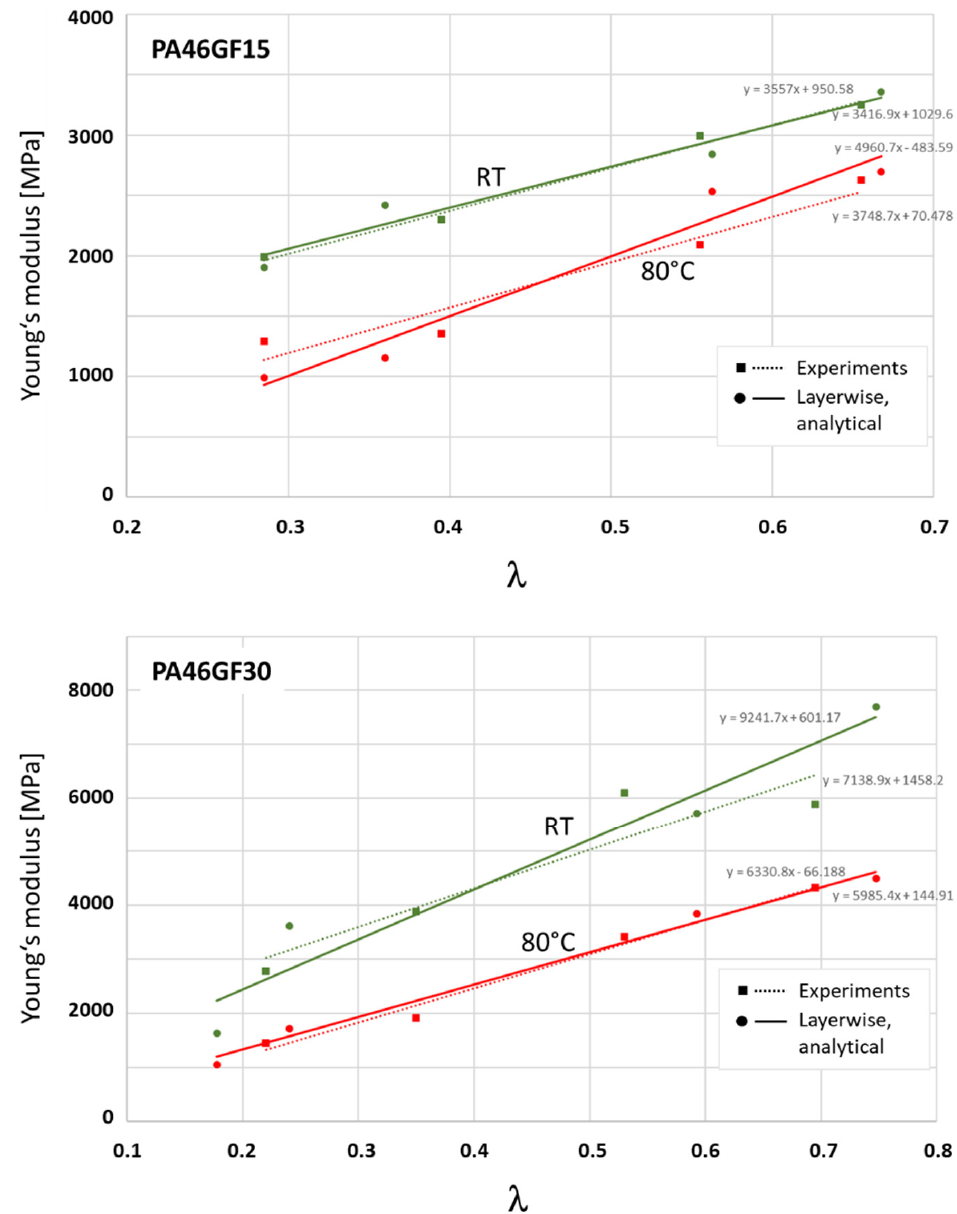
Figure 5. Experimentally determined Young’s modulus of the specimens and the layerwise analyt- ically resolved Young’s modulus versus the eigenvalue λ of the fiber orientation tensor for a 15% fiber weight content ( top ) and 30% fiber weight content ( bottom ). Each modulus is related to the individual eigenvalue, which is valid for the same direction. Equations for linear approximation are given in the diagrams.